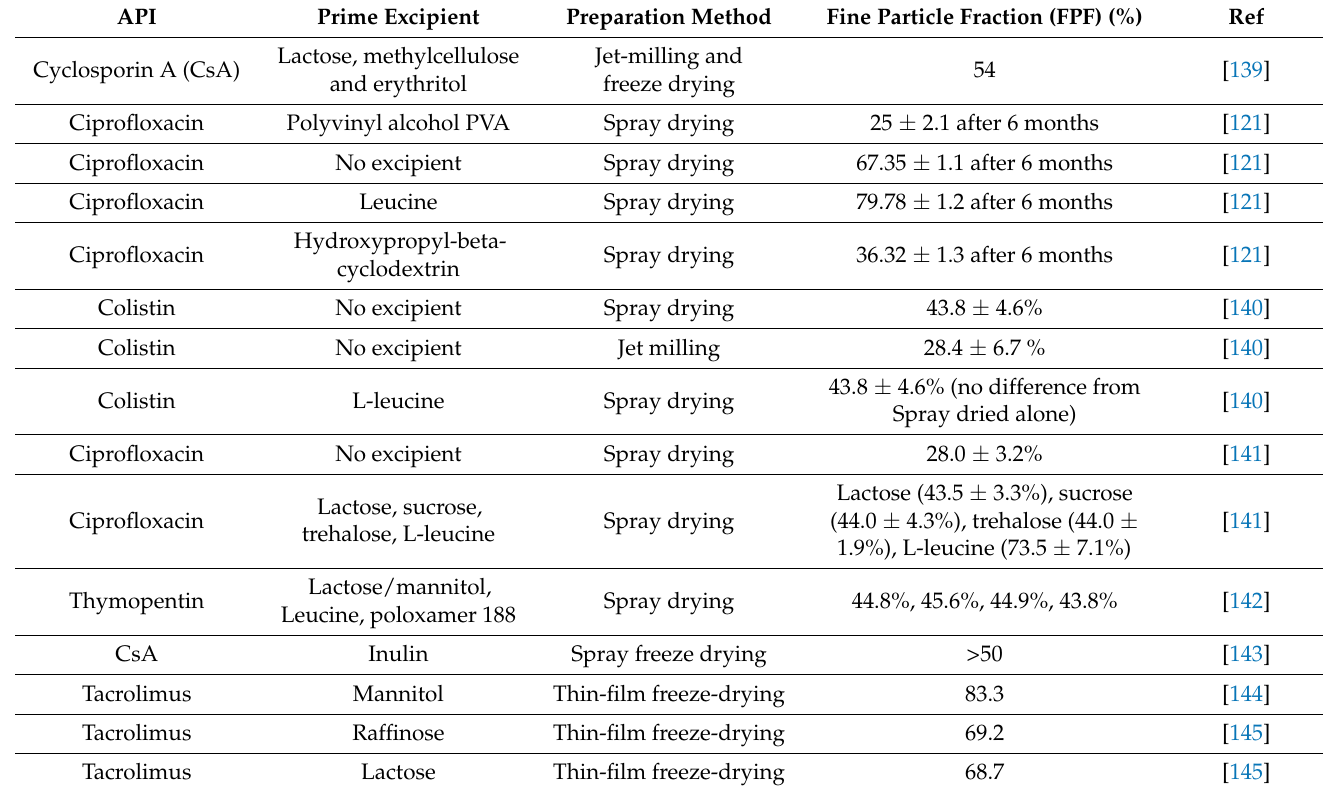
Table 7. Application of coamorphous solid dispersions prepared using different preparation methods. The inclusion of PASD of ciprofloxacin was shown to identify the apparent benefits of polymeric solid dispersions compared to coamorphous solid